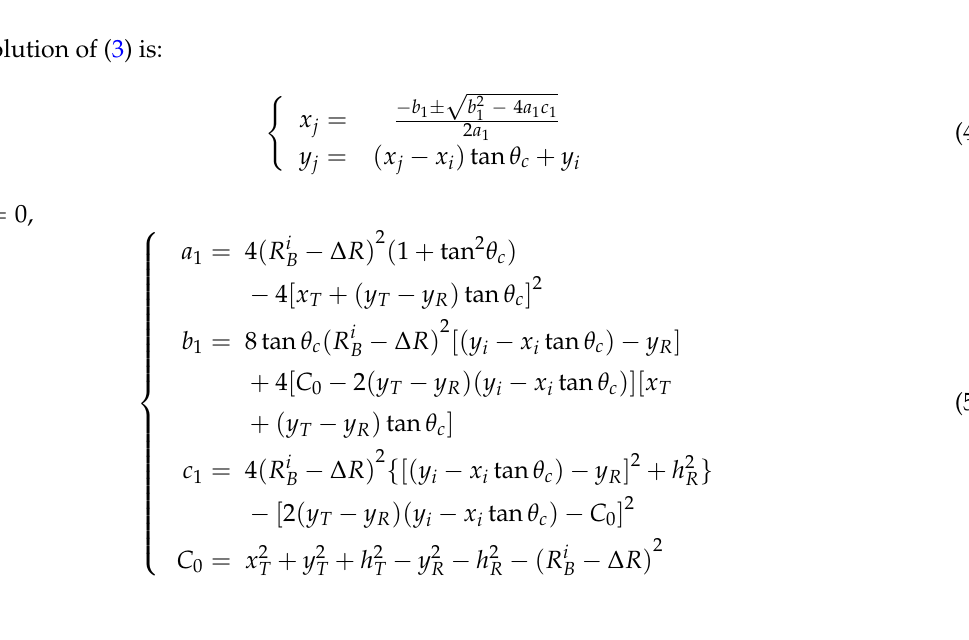
Figure 6. Azimuth reference signal construction. ( a ) Processing result after range compression and RCMC; ( b ) targets’ position